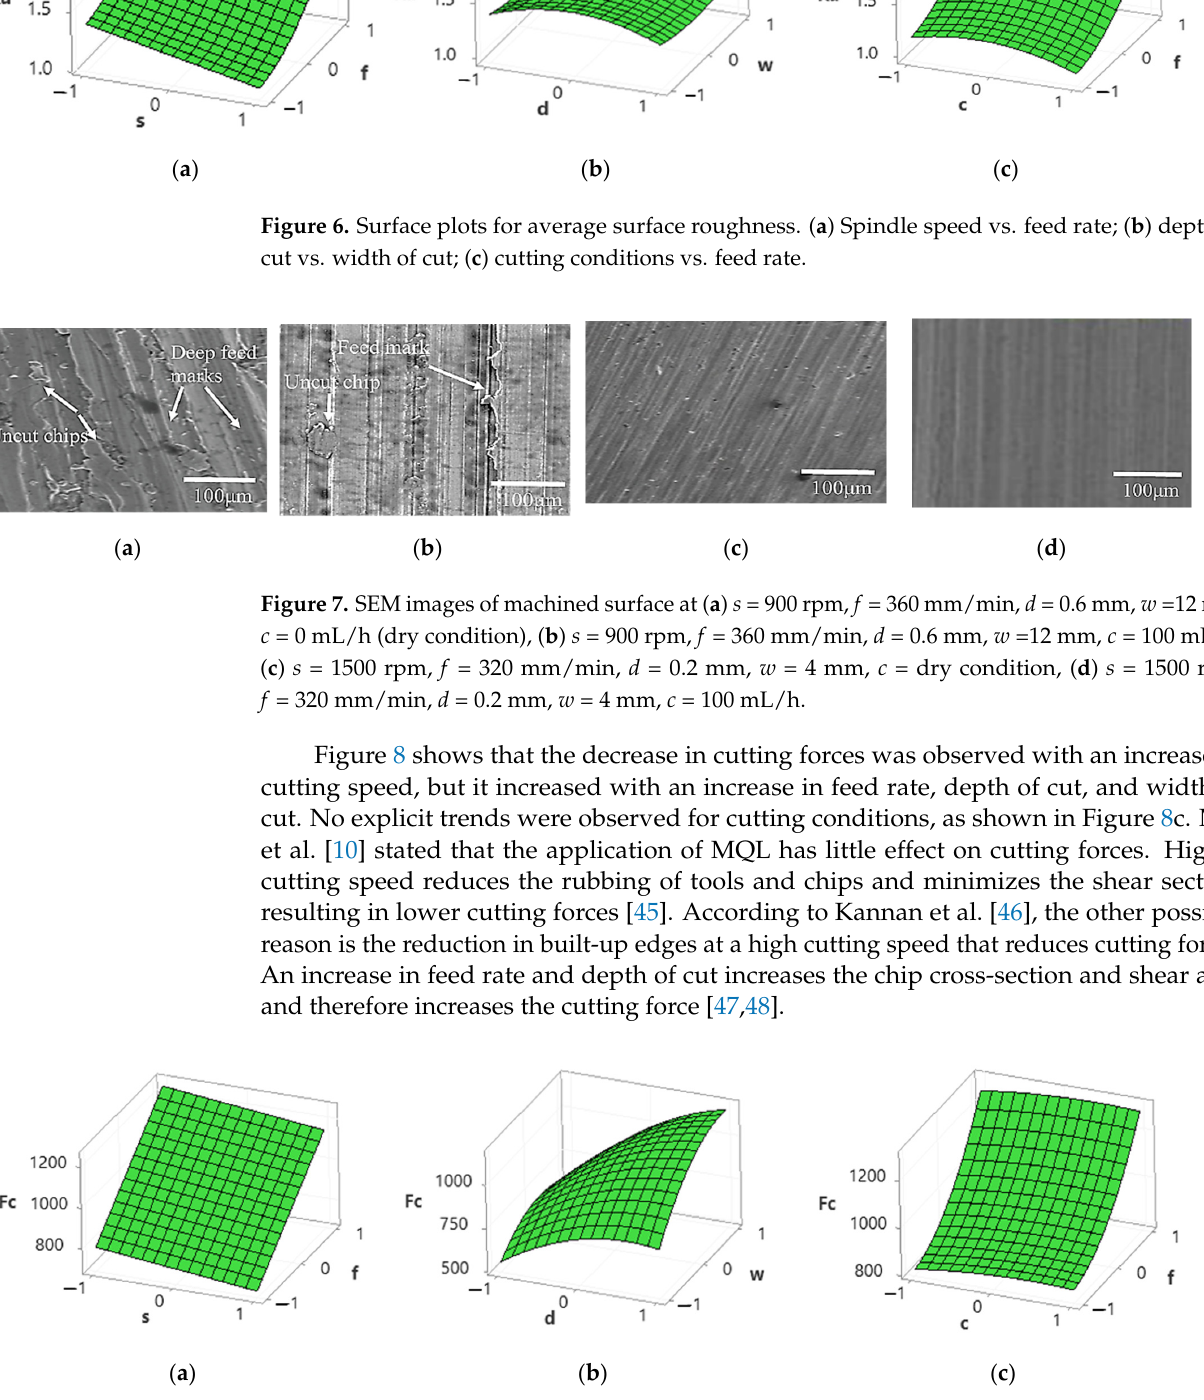
( c ) Figure 9. Surface plots for tool wear. ( a ) Spindle speed vs. feed rate; ( b ) depth of cut vs. width of cut; ( c ) cutting conditions vs. feed rate. ( a ) ( c ) Figure 10. Surface plots for material removal rate. ( a ) Spindle speed vs. feed rate; ( b ) depth of cut vs. width of cut; ( c ) cutting conditions vs. feed rate. 3.3. Single ‐ Response Optimization Based on S/N Ratios The responses were optimized individually using signal ‐ to ‐ noise (S/N) ratios. For av ‐ erage surface roughness (Ra), cutting forces (Fc), and tool wear (TW), the smaller ‐ the ‐ bet ‐ ter ‐ quality characteristic based on S/N ratios was applied using Equation (2). For material removal rate (MRR), the larger ‐ the ‐ better ‐ quality characteristic based on S/N ratios was employed using Equation (3). The results are tabulated in Table 8. Larger values of S/N ratios indicate an excellent performance of responses. For Ra, the larger value of S/N ratios observed was 0.80 at experimental run 12, having cutting speed (cid:4666)𝑠(cid:4667) , depth of cut (cid:4666)𝑑(cid:4667) and cutting conditions (cid:4666)𝑐(cid:4667) at a high level, feed rate (cid:4666)𝑓(cid:4667) at a low level, and width of cut (cid:4666)𝑤(cid:4667)